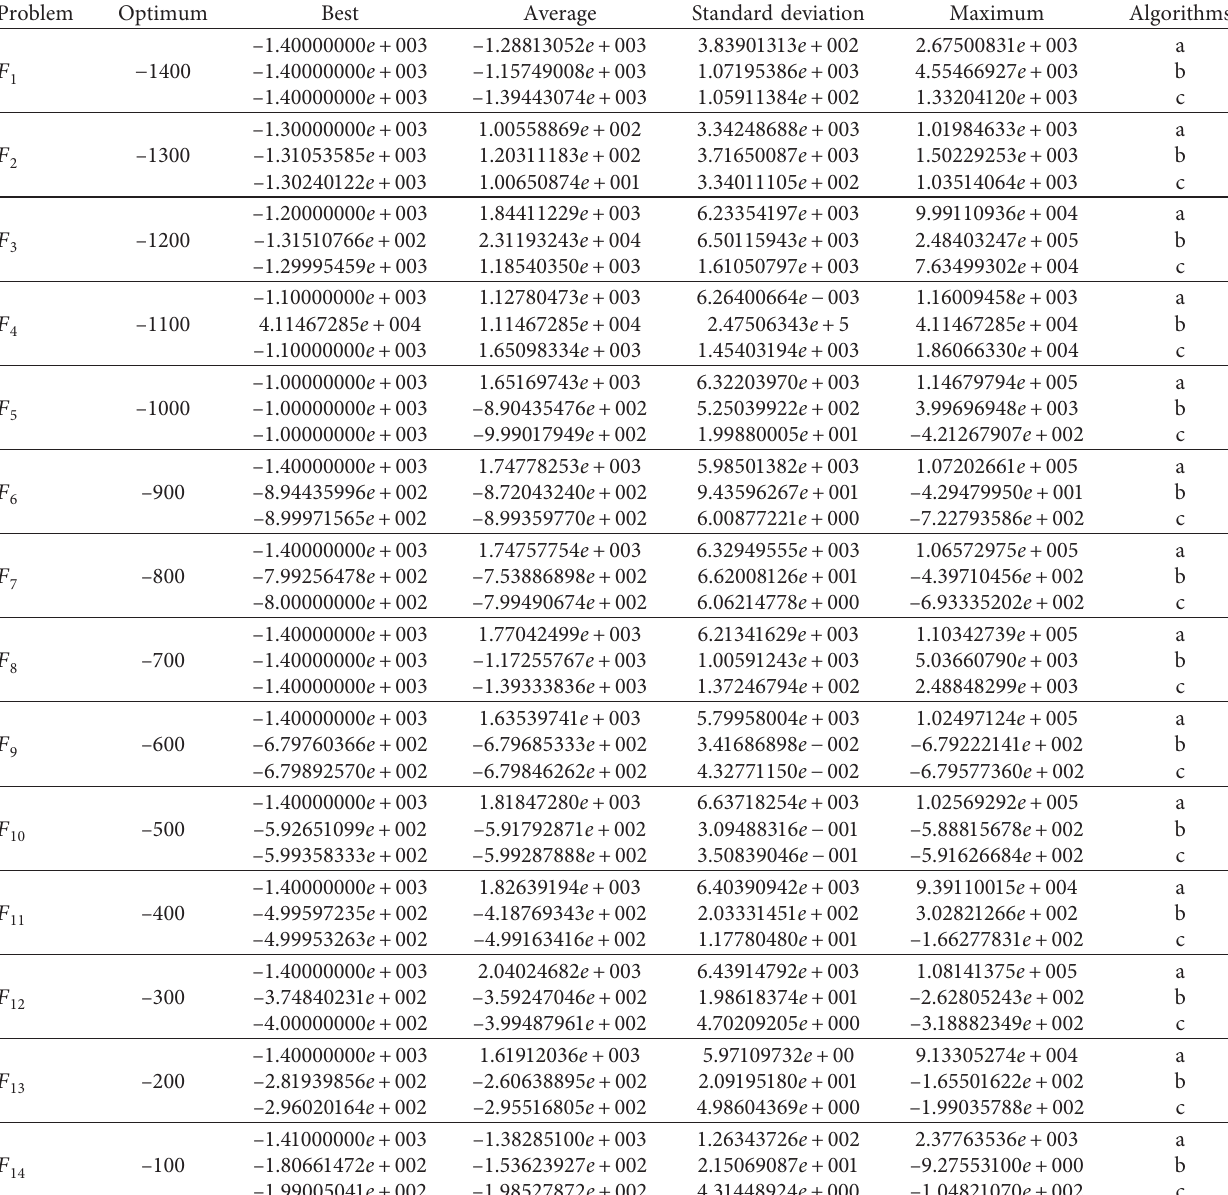
Table 2: The experimental results of (a) MSIA, (b) ACO, and (c) FA for CEC ′ 13 benchmark functions in 10 dimensions